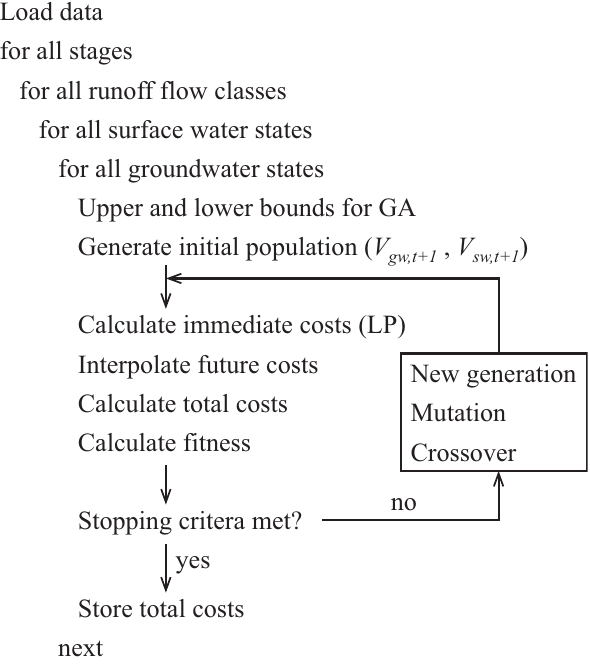
Figure 3. SDP optimization algorithm